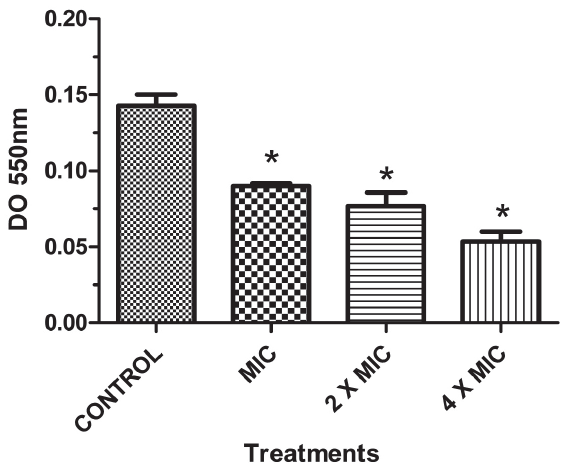
FIGURE 4 - Effects of carvacrol at MIC (312 µg mL -1 ), 2 x MIC 624 (µg mL -1 ), 4 x MIC (1250 µg mL -1 ) on the metabolic